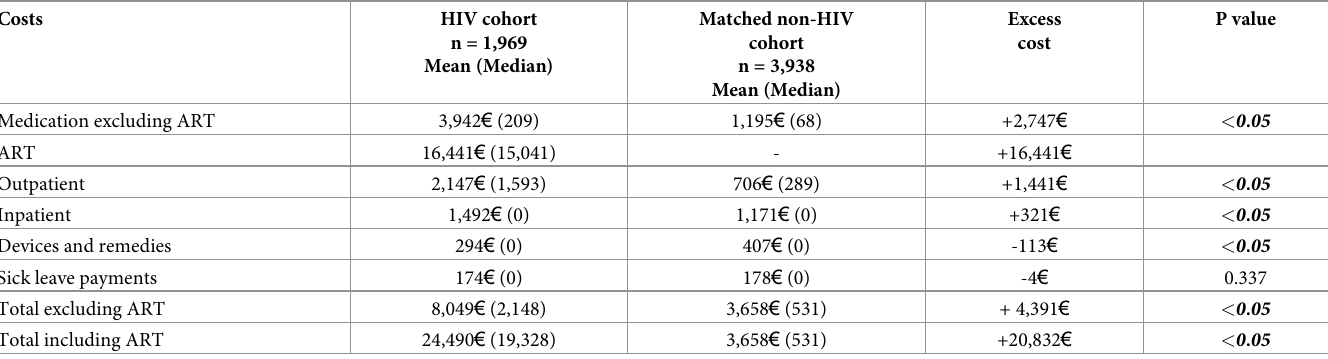
Matched non-HIV cohort